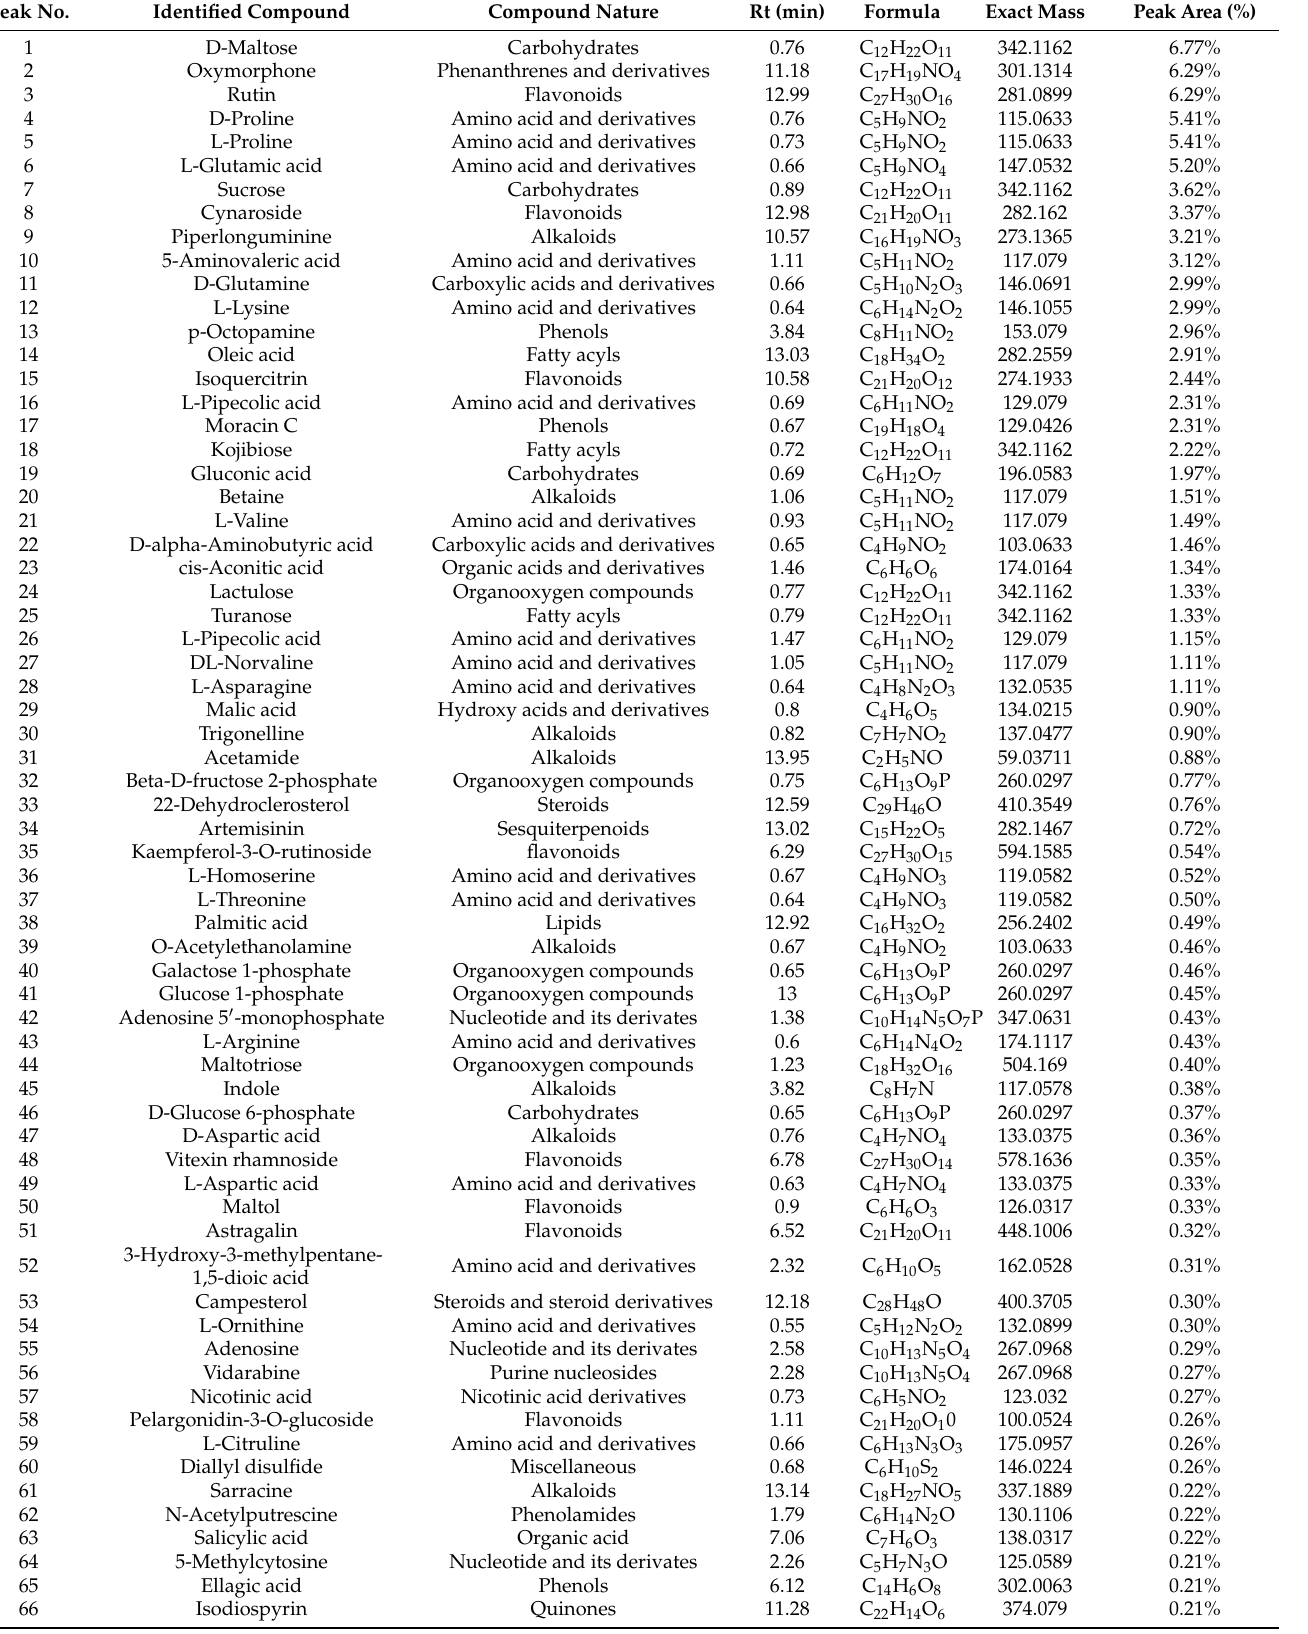
Table 3. Compounds identified in Fragment 1 from P. kleiniana Wight et Arn via UHPLC–MS analysis. Peak